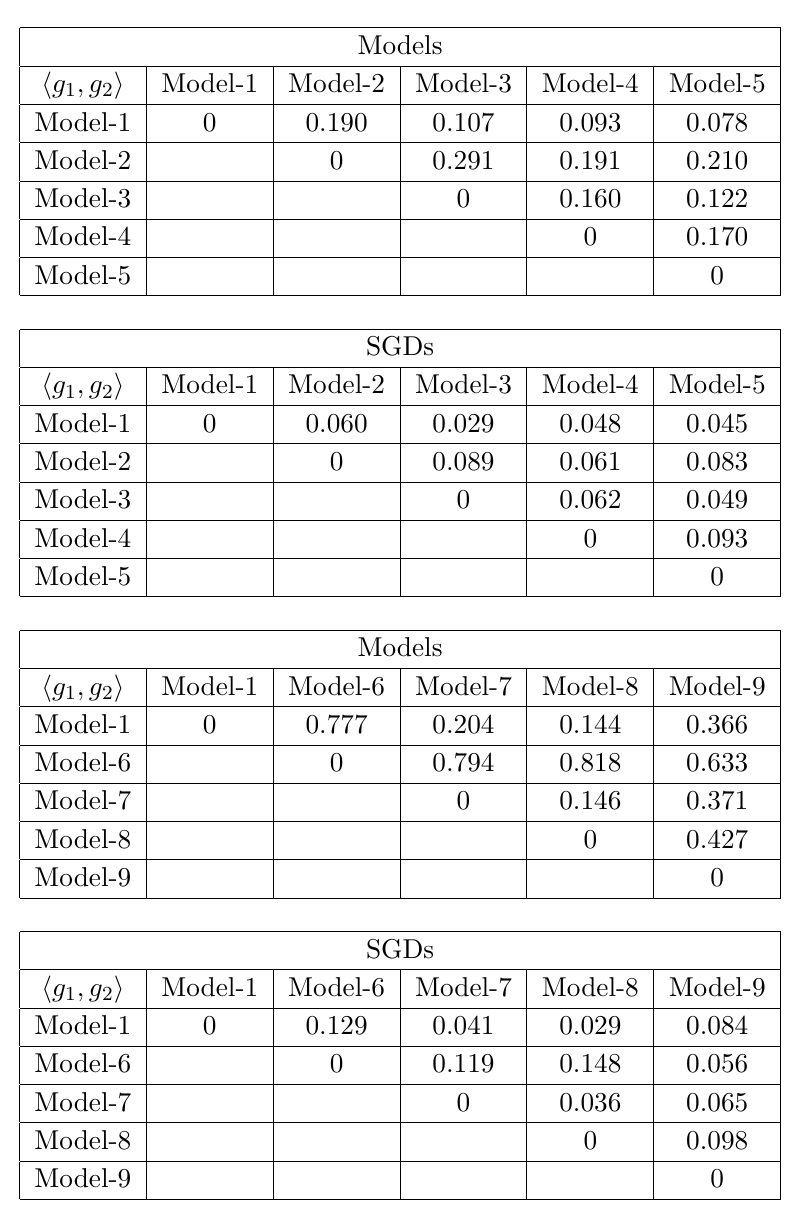
Table 1 . The differences between the Models and the